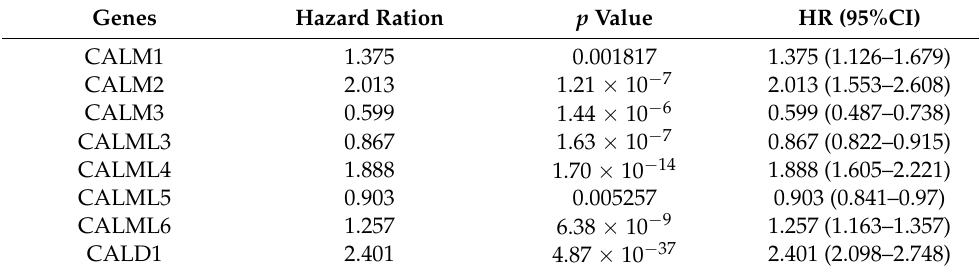
Table 1. Univariate Cox analysis based on genes of genes encoding calmodulin-dependent proteins.